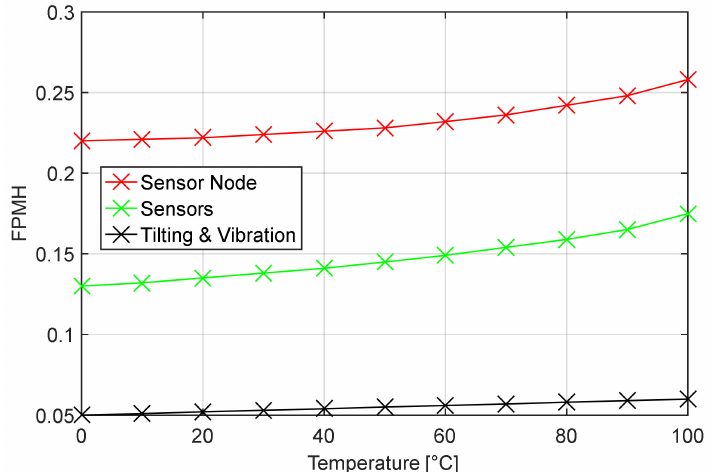
Figure 7. Expected number of failures for each individual subsystem composing the sensor node structure as a function of the temperature and considering the ‘on demand’ mode. Red line: failure modes of whole sensor node; light green line: failure rates of the sensors module; yellow line: failure mode of the Tilting and Vibration module in 100%